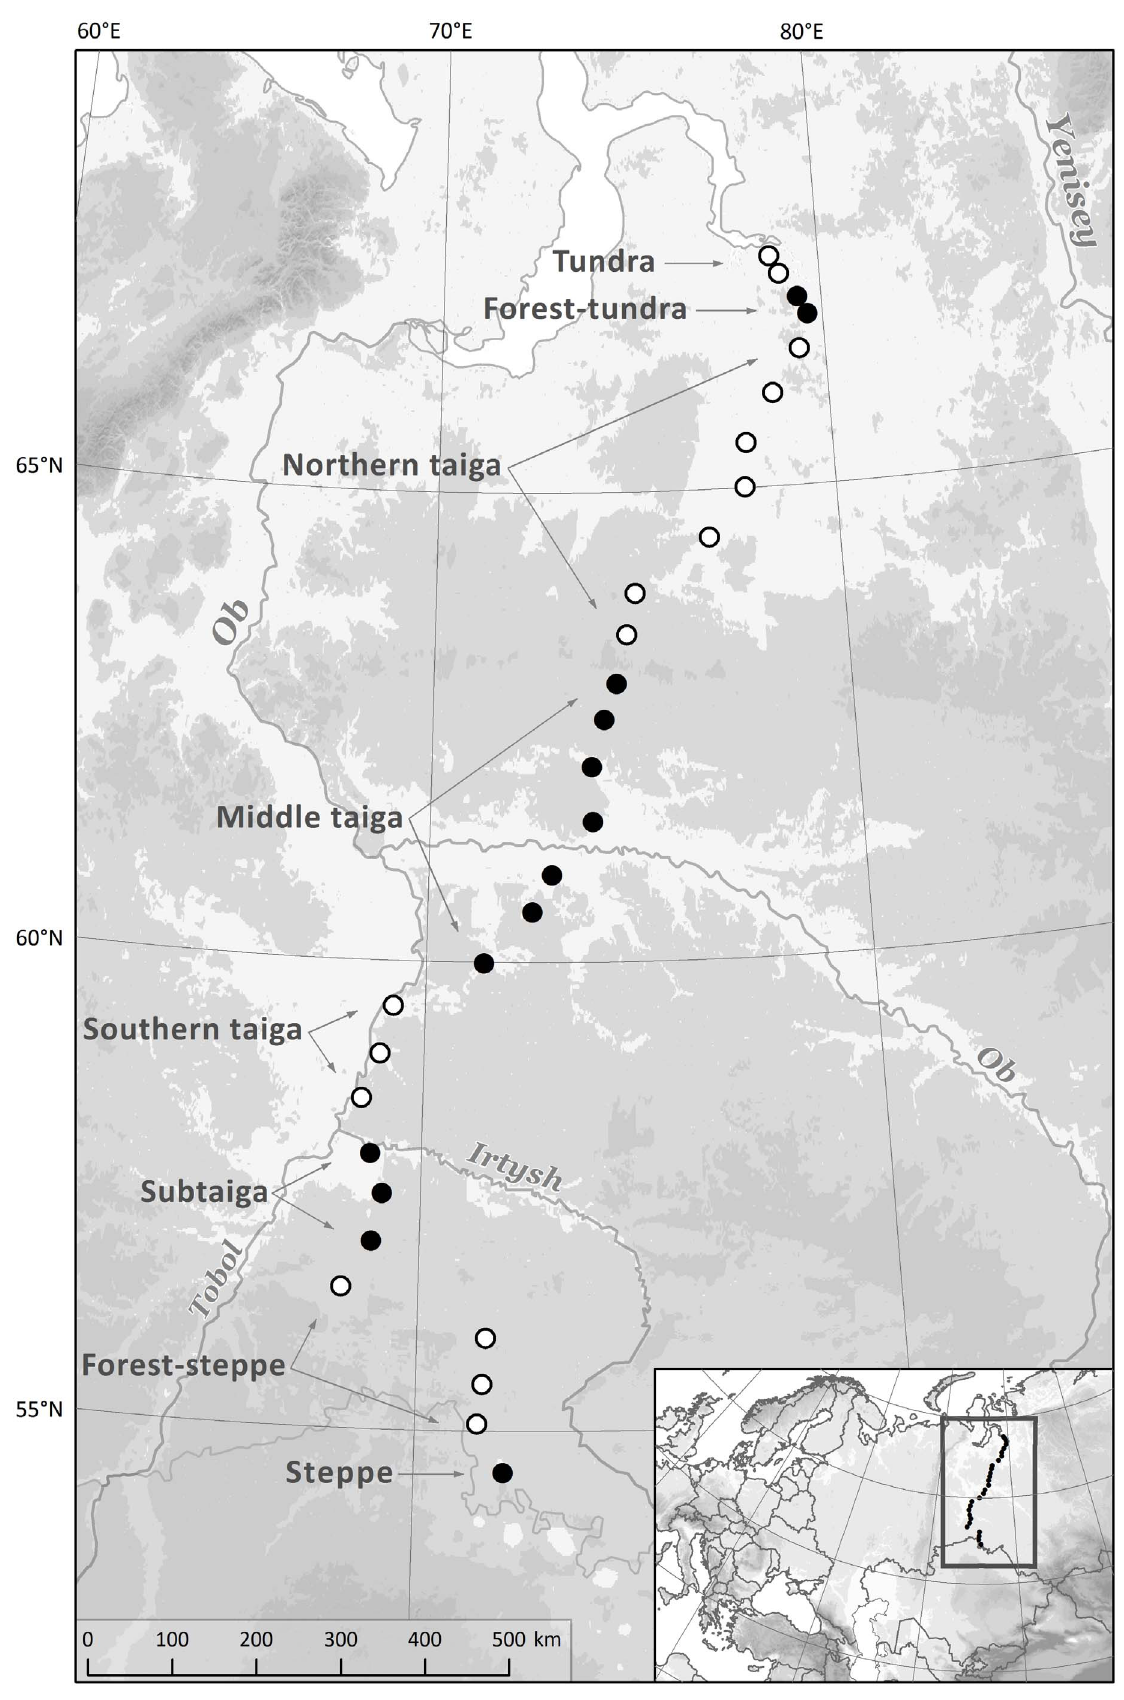
Figure 1. Study area with the position of 29 sampling sites along the transect. doi:10.1371/journal.pone.0104035.g001 PLOS ONE | www.plosone.org